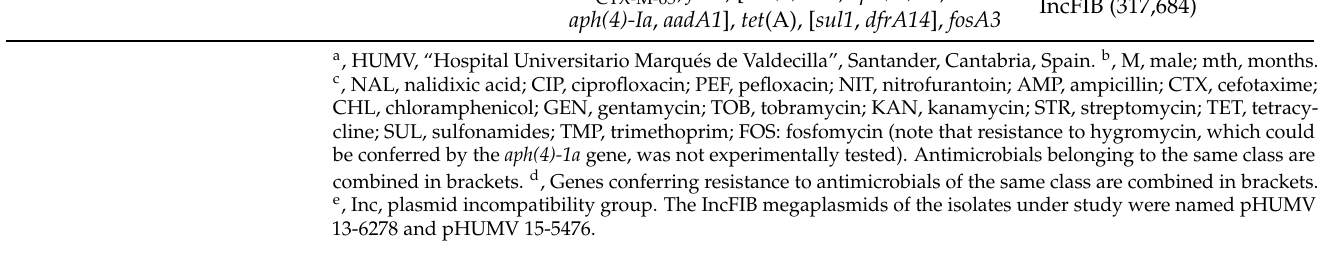
Table 2. Minimum inhibitory concentration (MIC, given in µ g/mL) of relevant antibiotics and heavy metals determined for Samonella enterica serovar Infantis strains from a Spanish